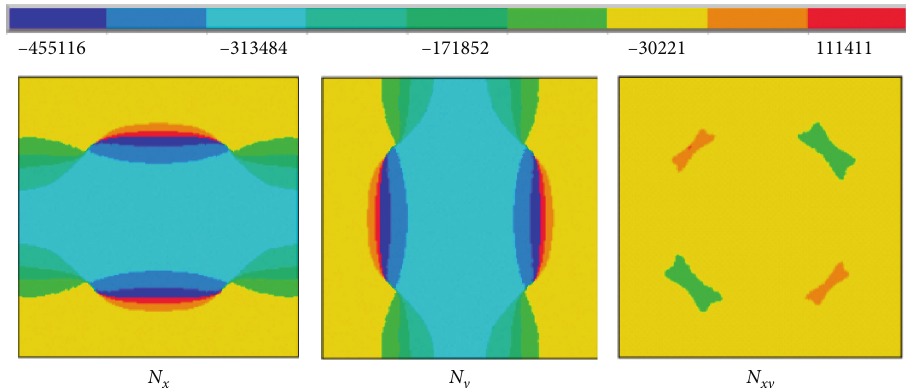
Figure 3: The variation over the plate of the in-plane resultant forces ( N/m ) .